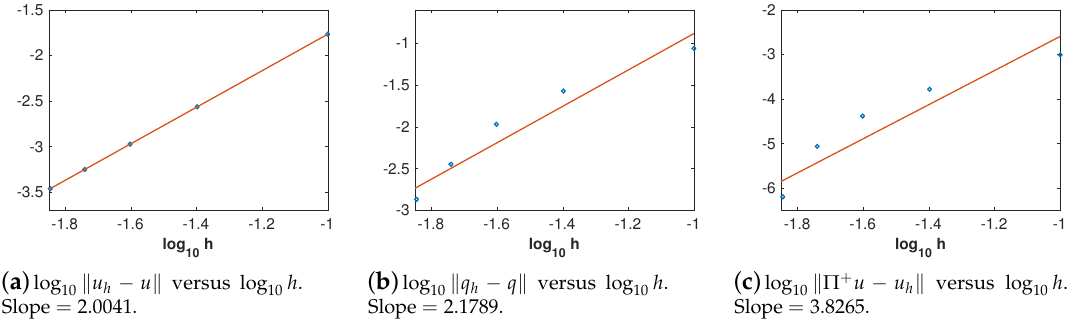
h , where E is the L 2 error at T = 0.5 with P 1 basis. Figure 1. log E versus log 10 10